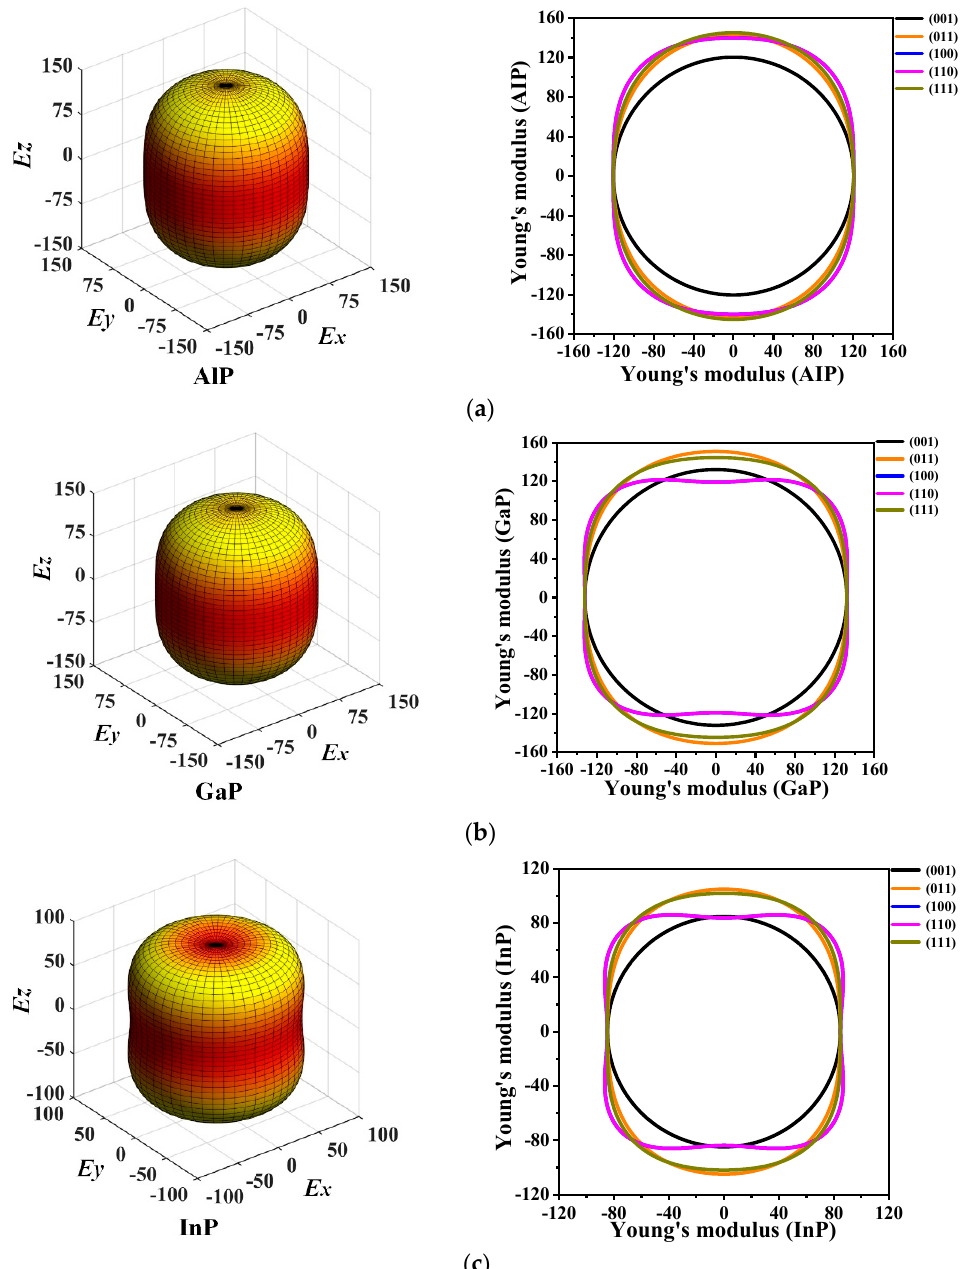
Figure 6. The 3D directional constructions and 2D representation of Young’s modulus E in the (001)-, (011)-, (100)-, (110)-, and (111)- plane for P 6 4 22-AlP ( a ), P6 4 22-GaP ( b ) and P6 4 22-InP ( c ). The calculated maximum values E max , minimum values E min , and ratios E max / E min of Young’s modulus E in each plane for P 6 4 22- X P ( X = Al, Ga, or In) are listed in Table 3. It is found that, in the (001)-plane, the minimum values of E max / E min for P 6 4 22- X P ( X = Al, Ga, or In) are all 1.000; thus, P 6 4 22- X P ( X = Al, Ga, or In) are attained with the isotropy in the (001)-plane. The maximum ratio E max / E min of Young’s modulus E is 1.206, with the largest anisotropy occurring in the (100)-, (110)-, and (010)-plane for P 6 4 22-AlP. For P 6 4 22-GaP, the maximum value of E max / E min is 1.273, which is attained in the (100)-, (110)-, and (010)-plane with larger anisotropy. The ratios E max / E min for P 6 4 22-InP are all 1.251 in the (100)-, (110)-, and (010)-plane, which is larger than in the other planes. Therefore, the (100)-, (110)-, and (010)-plane of P 6 4 22-InP exhibit higher anisotropy. In the (100)-, (110)-, and (010)-plane for P 6 4 22- X P ( X = Al, Ga, or In), the ratios E max / E min of Young’s modulus are 1.206, and 1.251, respectively. In the (100)-, (110)-, and (010)-plane, P 6 4 22-AlP exhibits the smallest anisotropy and P 6 4 22-GaP exhibits the largest anisotropy. From the (011)-plane to the (111)-plane, P 6 4 22-InP exhibits the largest anisotropy with E max / E min = 1.237, and P 6 4 22-GaP exhibits the smallest anisotropy with E max / E min = 1.147. Table 3. The calculated maximum values E max , minimum values E min and ratios E max / E min of X P ( X = Al, Ga, or In) in the P 6 4 22 phase via the method of GGA-PBE. Planes Materials E max E min Ratio Planes Materials